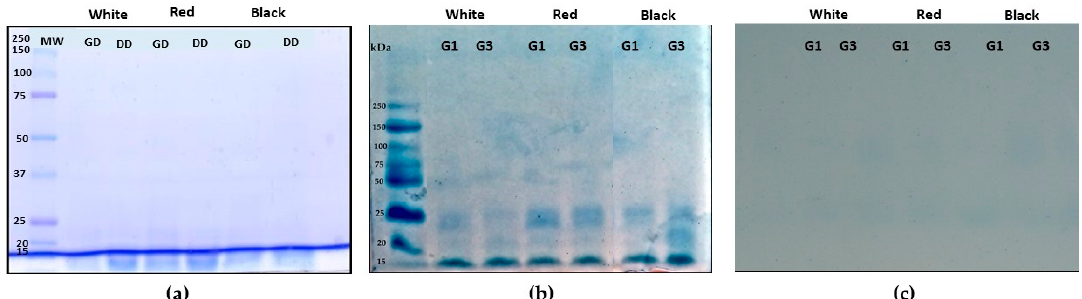
Figure 5. SDS-PAGE analysis of gastric and duodenal digests from non-germinated and germinated white, red and black quinoas. ( a ) Gastric and duodenal digest of QPI from non-germinated quinoa, ( b ) gastric digests of quinoas germinated, ( c ) duodenal digests of white, red and black quinoas germinated, GD (gastric digests), DD (duodenal digest), G1 (1 day of germination) and G3 (3 days of germination).